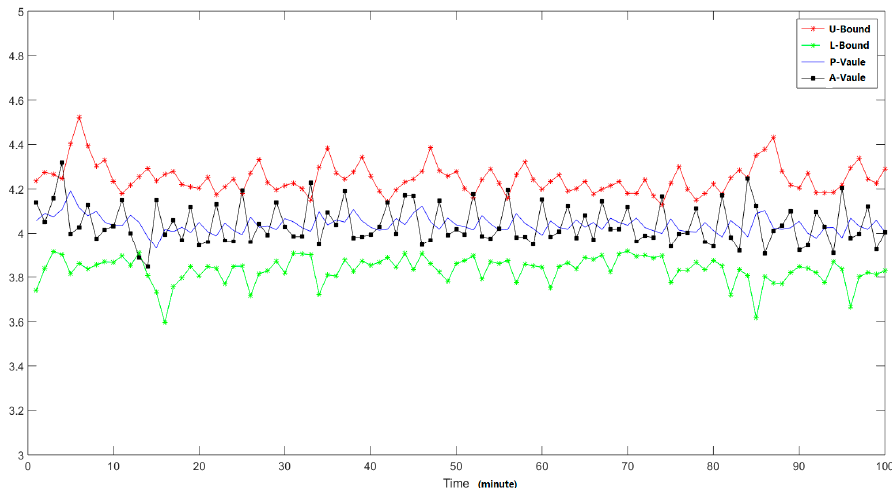
Figure 8. Feature changing trends of all the nodes.